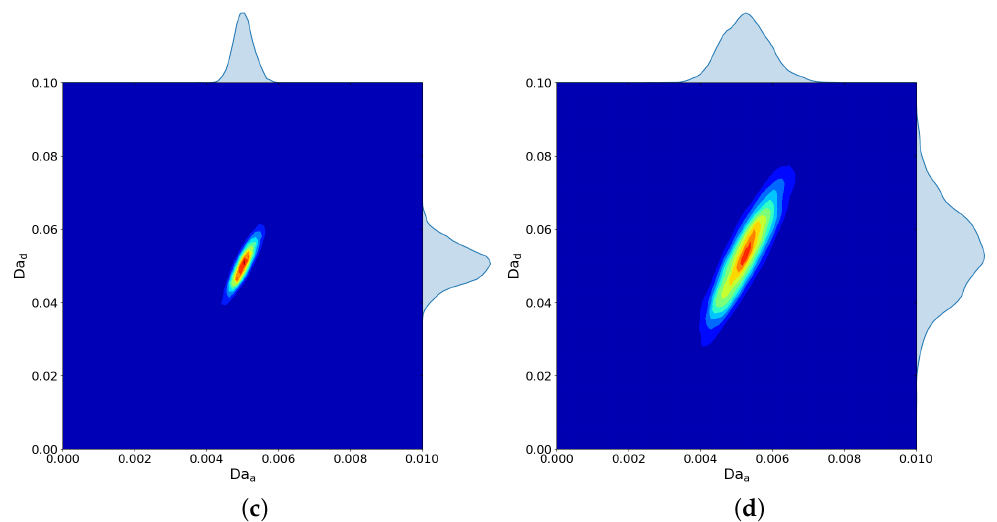
Figure 3. MCMC outputs for MH where results was obtained for: ( a ) measurements with 0.01 noise variance, ( b ) measurements with 0.05 noise variance, ( c ) ten different measurements with 0.01 noise variance, ( d ) ten different measurements with 0.05 noise variance.